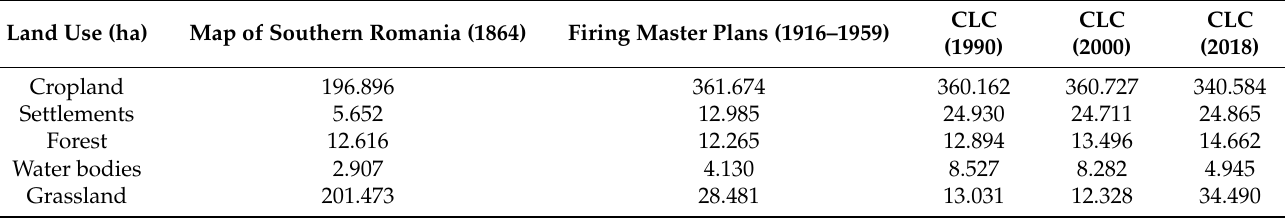
Table 1. Area (ha) of lands with different uses on the Map of Southern Romania, Firing Master Plans and Corine Land Cover, in Central B ă r ă